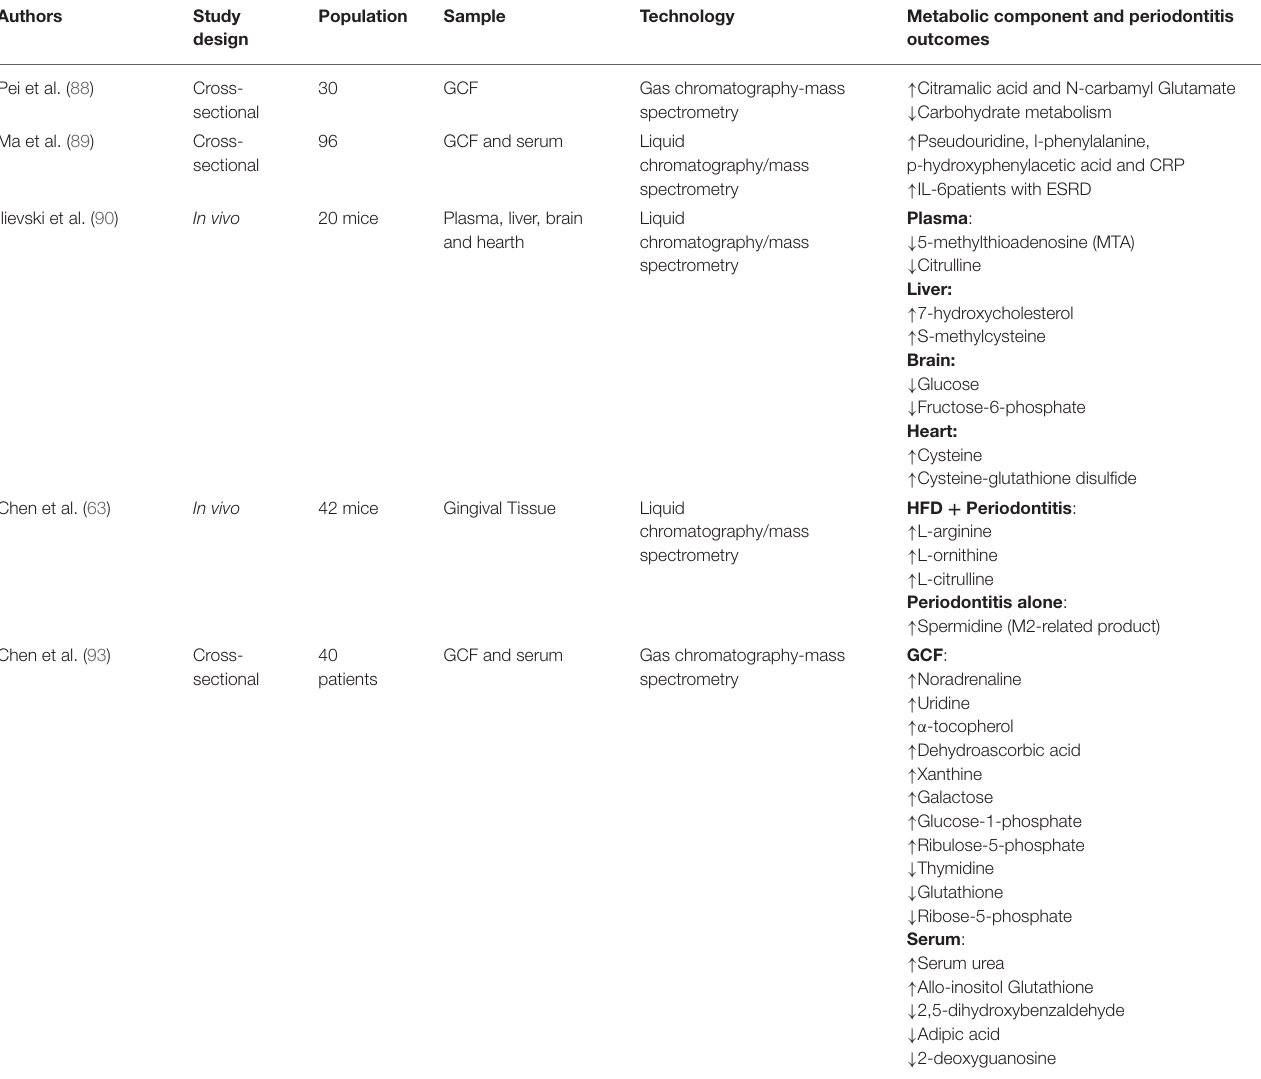
TABLE 2 | Some metabolic approaches in periodontitis.